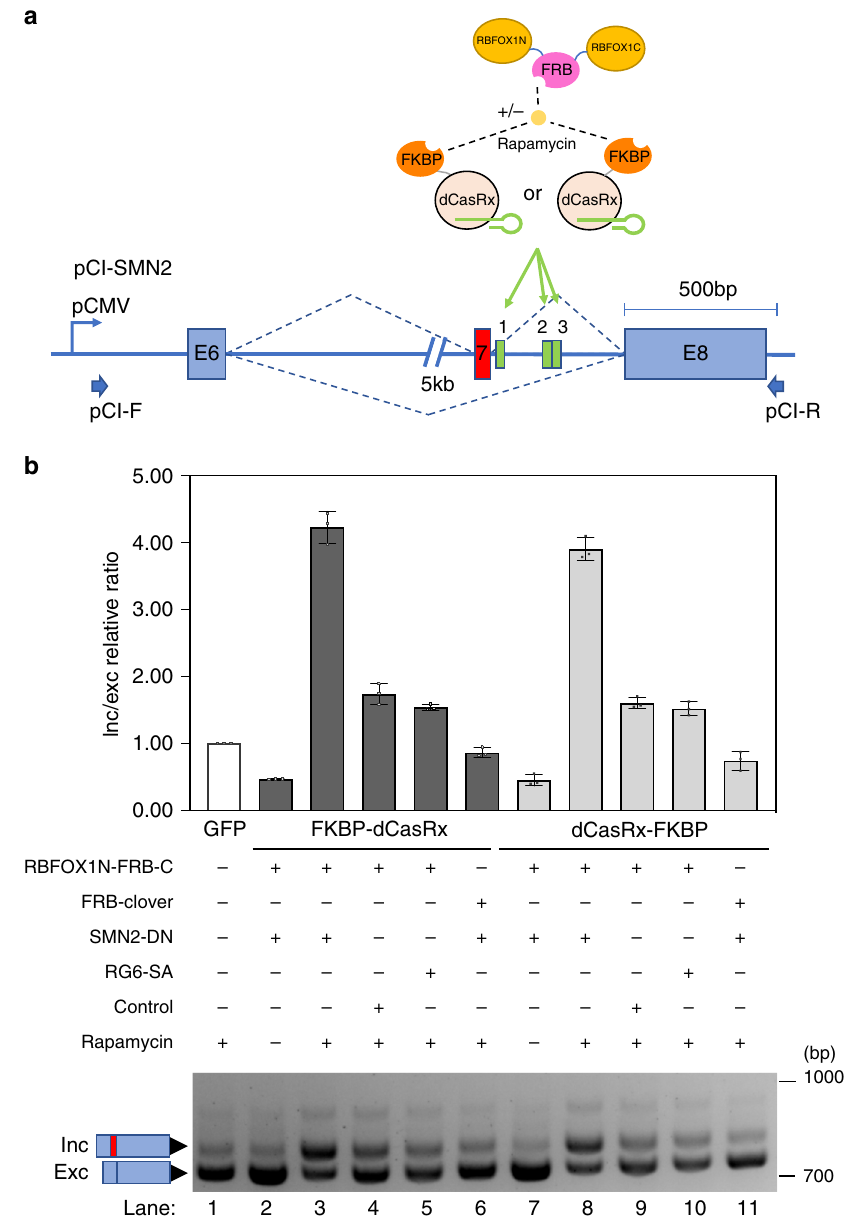
Fig. 5 Chemically inducible exon activation by iCASFx. a Schematic of the two-peptide CRISPR arti fi cial splicing factors inducible by rapamycin. The RNA binding module (FKBP- dCasRx or dCasRx-FKBP) and effector module (RBFOX1N-FRB-C) containing the splicing activator domains are expressed separately as two peptides, fused to FKBP or FRB, respectively. FKBP and FRB can be induced to interact by rapamycin, bringing together the RNA binding module and the splicing activator module, and when guided by gRNAs, assemble at the target to activate exon inclusion. b Upper panel shows inclusion/ exclusion (inc/exc) ratio fold-changes assayed by qRT-PCR on SMN2 minigene transcripts in cells co-transfected with the indicated constructs, and cultured with ( “ + ” ) or without ( “ − ” ) rapamycin. Fold-changes are relative to GFP-transfected sample. Data are represented as mean ± SD ( n = 3). Lower panel shows a gel image of semi-quantitative splicing RT-PCR of SMN2 minigene transcripts in cells co-transfected with the indicated constructs, and cultured with ( “ + ” ) or without ( “ − ” ) rapamycin. Uncropped gel images and qRT-PCR values are included in the Source Data fi